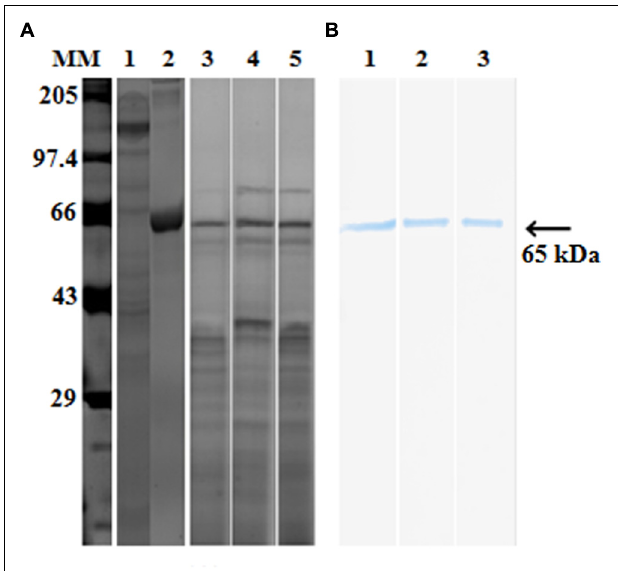
FIGURE 2 | Proteolytic processing of pro-Cry1Ac to active toxin by midgut bacterial proteases. Proteases (30 µ g) from midgut bacteria were incubated with pro-Cry1Ac (10 µ g) for 1 h. Active Cry1Ac (band at 65 kDa) was detected on (A) SDS-PAGE [molecular markers (MMs), lane 1- pro-Cry1Ac, lane 2- active Cry1Ac, lane 3 – IVS1, lane 4 – IVS2 and lane 5 – IVS3] and (B) Western blot (lane 1- IVS1, lane 2- IVS2, and lane 3- IVS3).